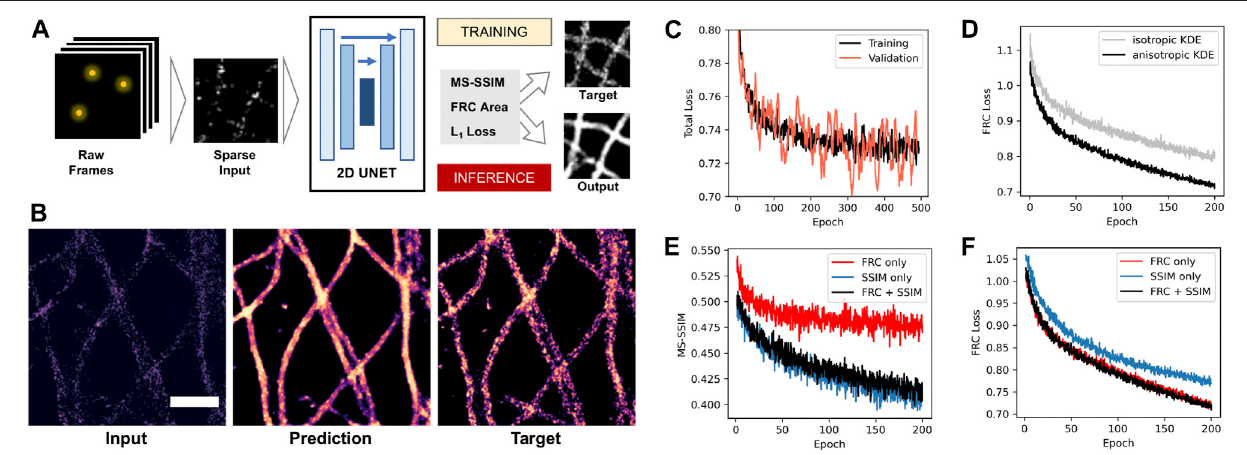
FIGURE 3 | Deep learning-based density reconstruction with FRC area loss. (A) Deep learning work fl ow using a 2D U-Net architecture to predict density images from sparse input. (B) Example of sparse input with 10% of localizations (left), network prediction after training (middle), and target image using the full dataset (right). Scale bar (cid:2) 0.5 µm (C) Total loss monitored during network training for training (black) and unseen validation images (orange). (D) FRC loss during training for target density images generated by classical isotropic Gaussian (grey) and anisotropic kernel density estimation (black). (E) Structural similarity index (MS-SSIM) during training for a network trained on FRC loss only (red), SSIM (blue) and both together (black). (F) FRC area loss during training for a network trained on FRC loss only (red), SSIM (blue), and both together (black).